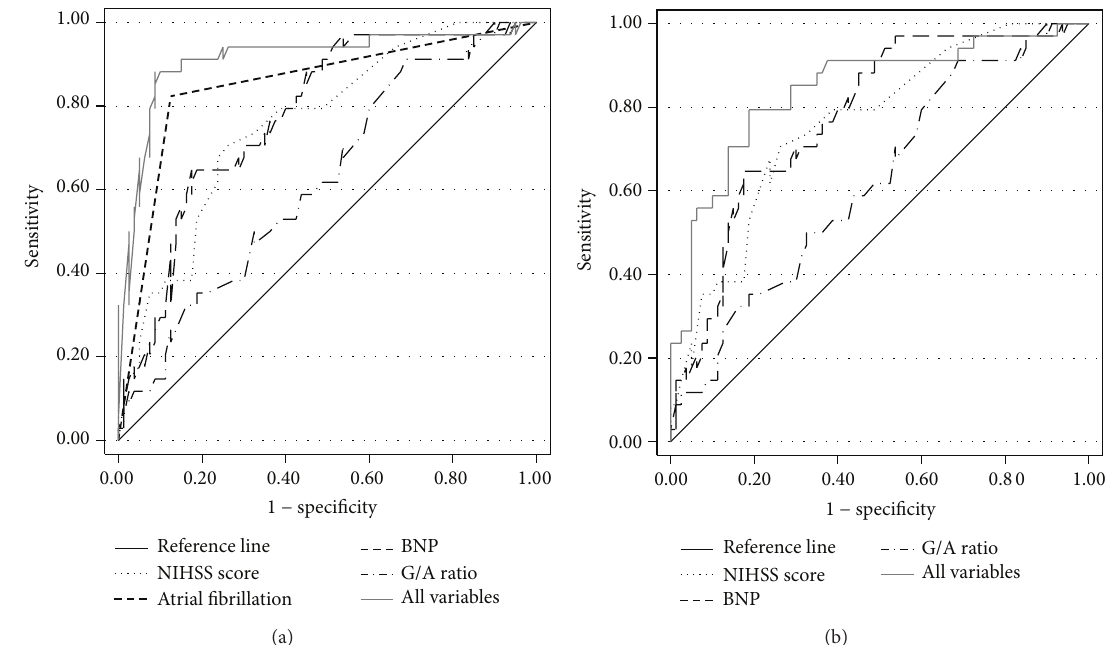
Figure 1: Receiver operating characteristic (ROC) curves for selected clinical variables among 114 patients (34 with cardioembolic stroke and 80 with stroke of other origins), alone or in combination in multiple logistic regression models. (a) Model with atrial fibrillation; (b) model without atrial fibrillation. See Table 3 for model